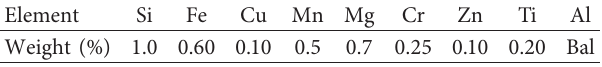
Figure 1: The cylindrical model with BCs for the die temperature of 400 ° C (melt temperature 800 ° C and pressure 130MPa). Table 1: Chemical composition of AA6082 aluminium alloy.